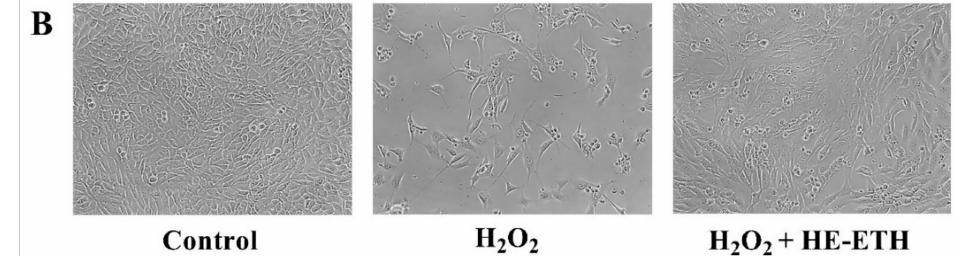
Figure4. ( A )Protectivee ff ectsofhotwater(HE-HWA)andethanolic(HE-ETH)extractsonH 2 O 2 -treated HT22 neurons measured by MTS viability assay and ( B ) morphology of the neurons (control, 250 µ M H 2 O 2 and 250 µ M H 2 O 2 + 400 µ g / mL HE-ETH) under light microscope. The results were expressed as percentage of viable cell versus control, with control considered as 100% cell viability. All values presented correspond to mean ± SD of three independent experiments ( n = 3). Values of #### p < 0.0001 compared with control, and ** p < 0.01; **** p < 0.0001 compared with H 2 O 2 -treated group were considered as statistically significant. Scale bar denotes 100 µ m.